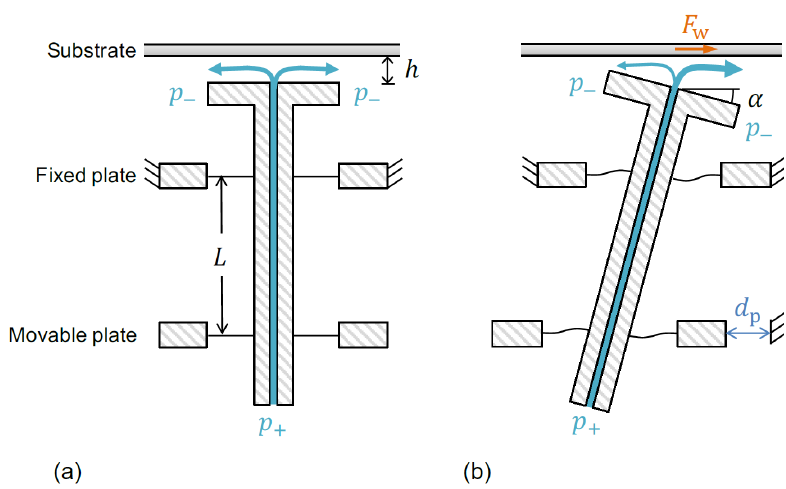
Figure 5. Schematic of a single flower of the Flowerbed in ( a ) neutral position and ( b ) actuated position. The force on the wafer is visualized in the actuated position